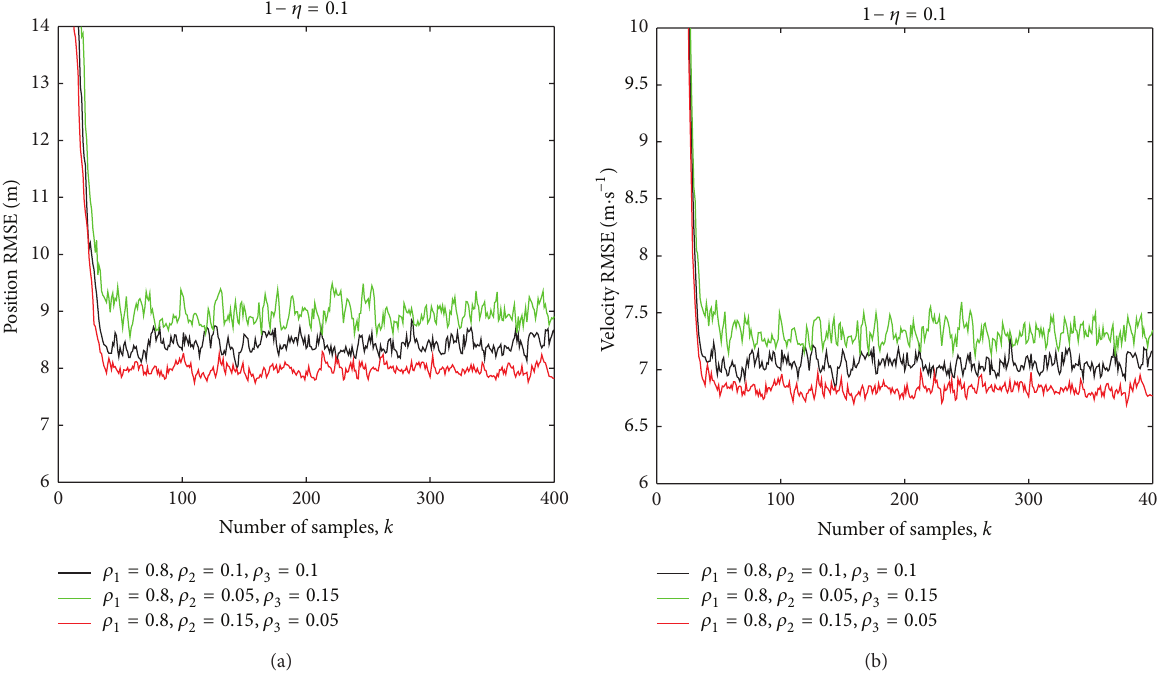
Figure 10: Comparison of the RMSEs for the proposed algorithm with different 𝜌 𝑞 (𝑞 = 1, 2, 3) : (a) position RMSE; (b) velocity